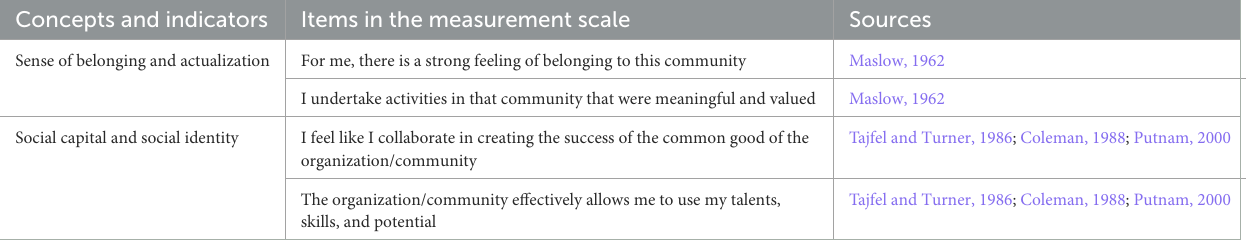
TABLE 4 Nomological network for the construct community experiences: youth-community experience